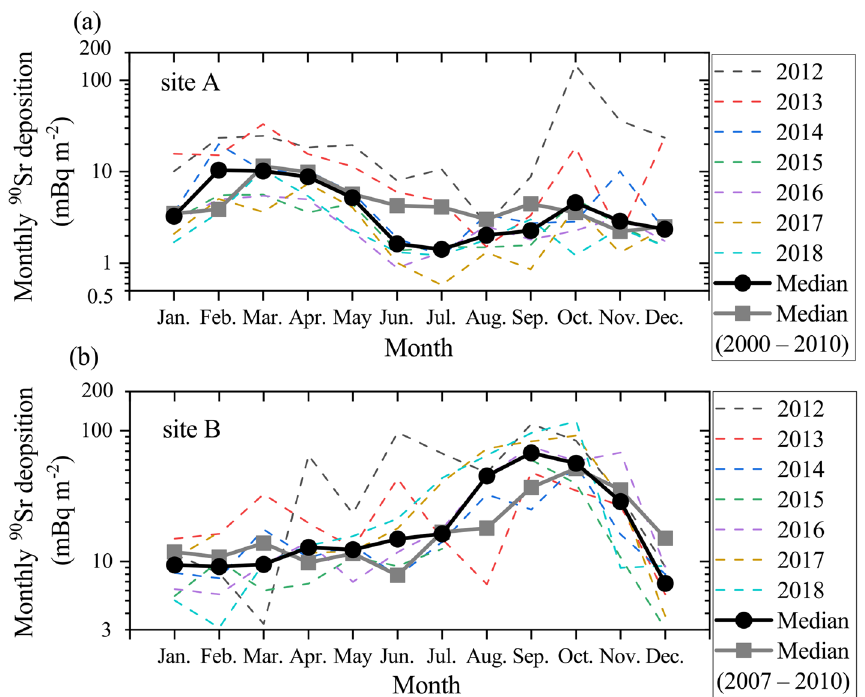
Figure 3. Seasonal changes in 90 Sr deposition from 2012 to 2018 at ( a ) site A and ( b ) site B. The black curves indicate the median values in each month after the FDNPP accident (from 2012 to 2018). The gray curves indicate those before the accident (from 2000 to 2010 at site A and from 2007 to 2010 at site